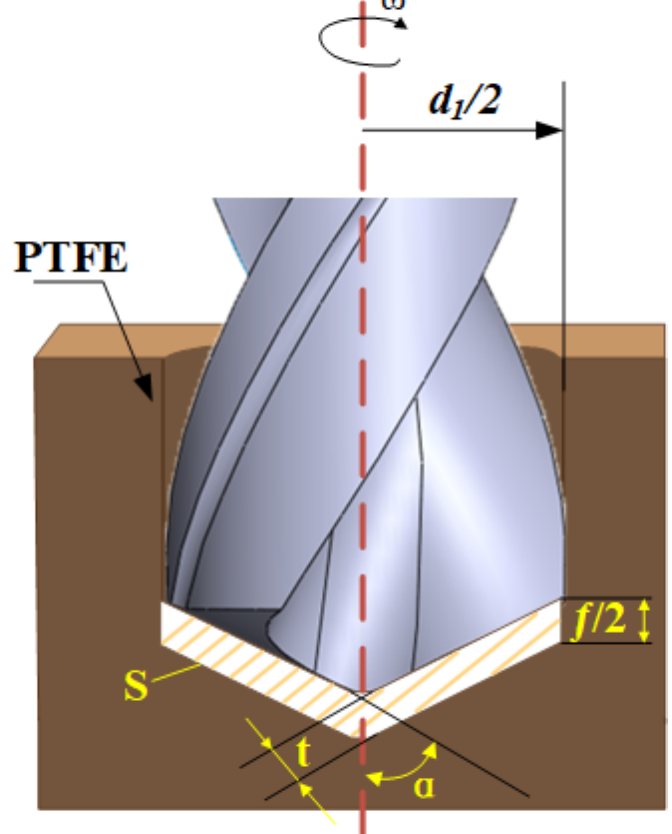
Figure 6. Diagram of drilling principle.